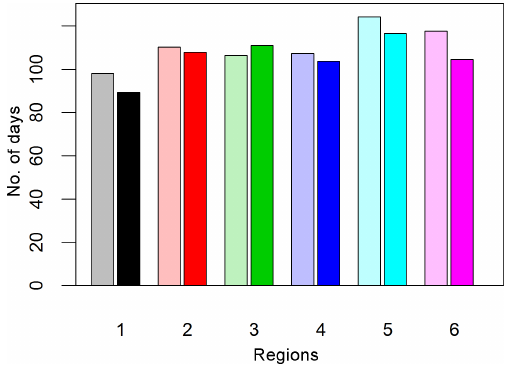
Figure 10. Number of compound hot and dry extremes in summer (JJA) (Ta < 90th percentile and EDI < 25th percentile), 1971–2000 (light colors) and 2021–2050 (dark colors), ensemble mean. The coloring corresponds to the regions in Fig.